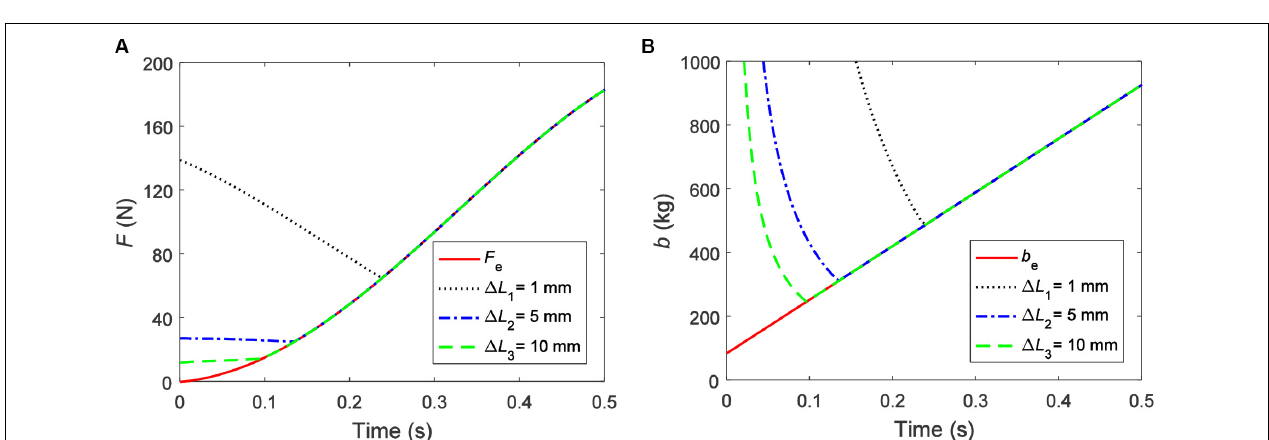
FIGURE 9 | Output characteristics of the magnetorheological inerter under different gap widths: (A) force and (B) inertance.